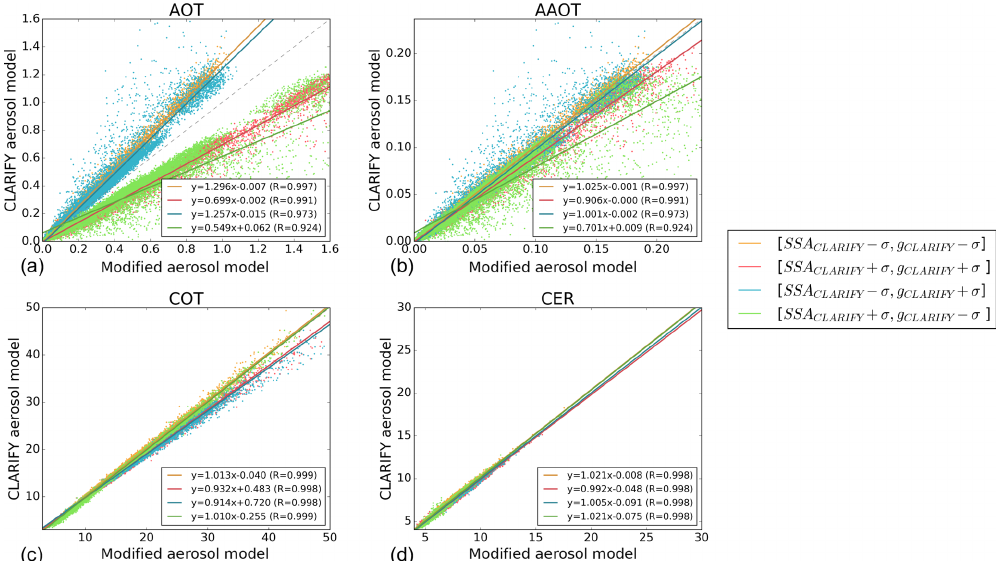
Figure 10. Similar to Fig. 9 but for the combined impact and the